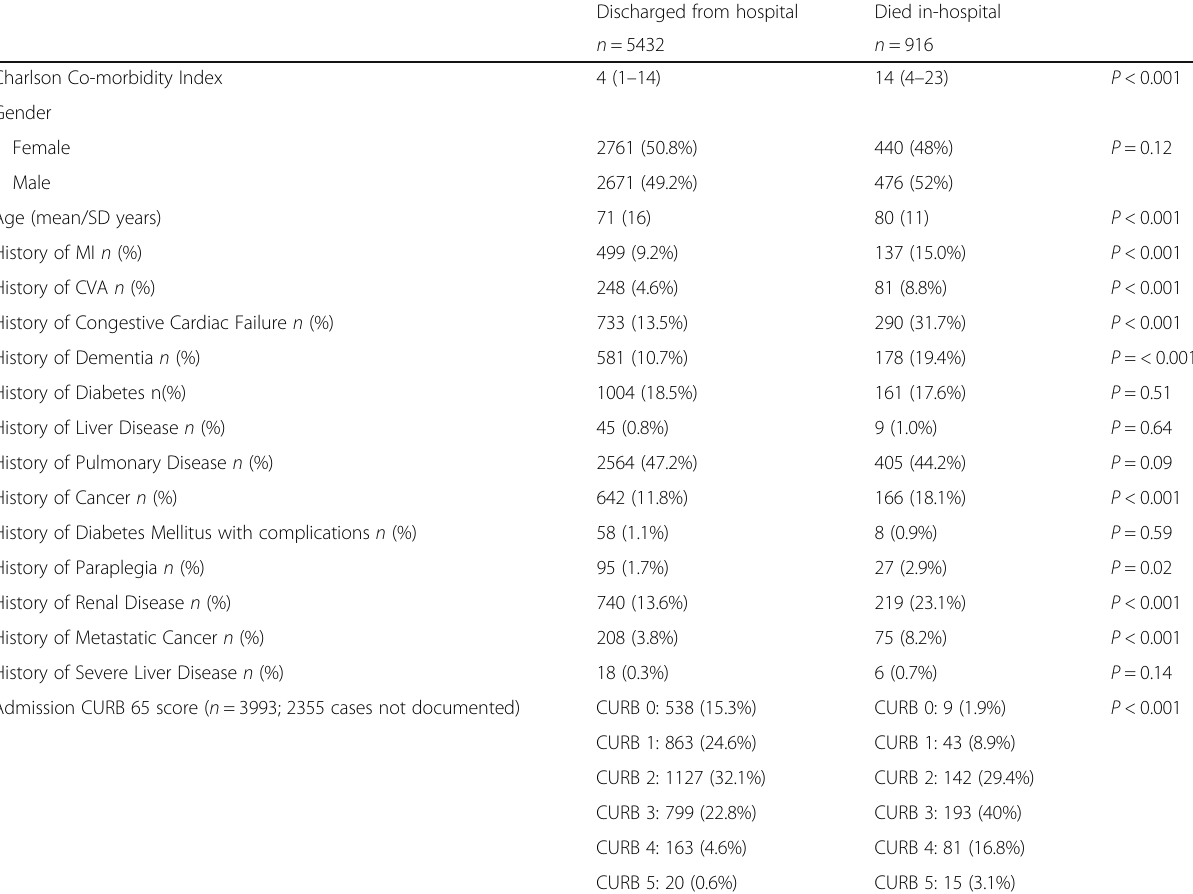
Table 2 Comparison of subjects who died in-hospital against those surviving to